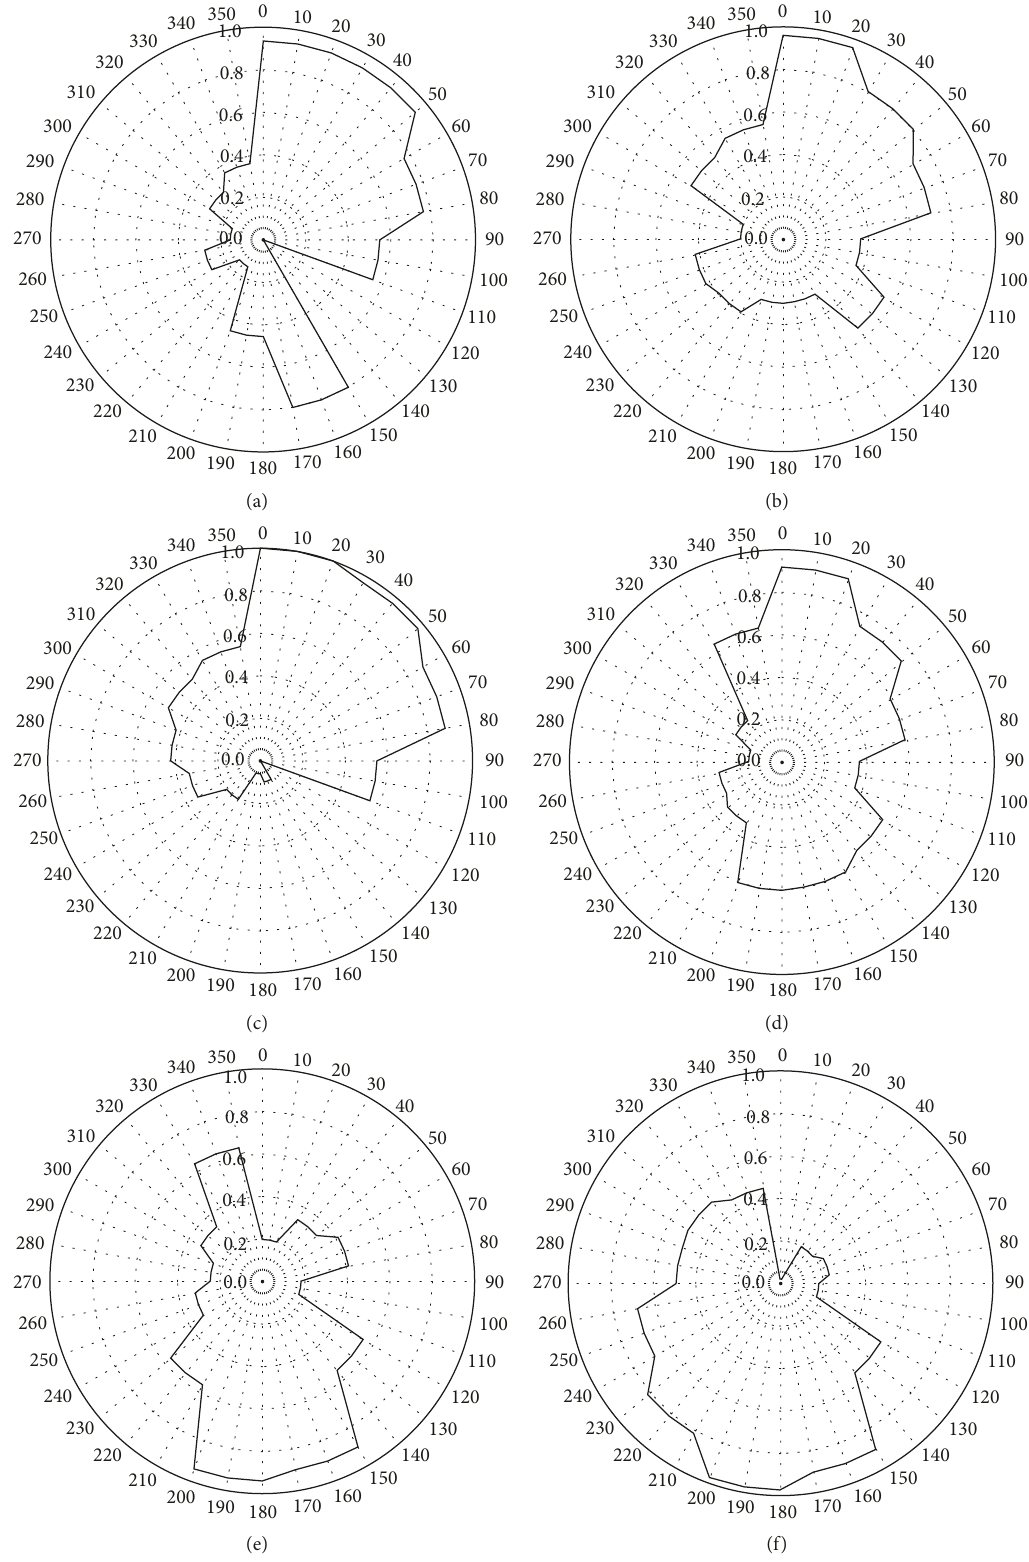
Figure 7: Rose plot of CPF for (a) the sum of PAHs, (b) the sum of hopanes, (c) the sum of n -alkanes, (d) the sum of 4-NO2-Phen and 2-OH-BA, (e) the sum of 3-OH-BA, 4-OH-BA, and 4-Me-PhA, and (f) the sum of o -PhA, m -PhA, p -PhA, 1,2,3-BA, 1,2,4-BA, and 1,2,4,5-BA at